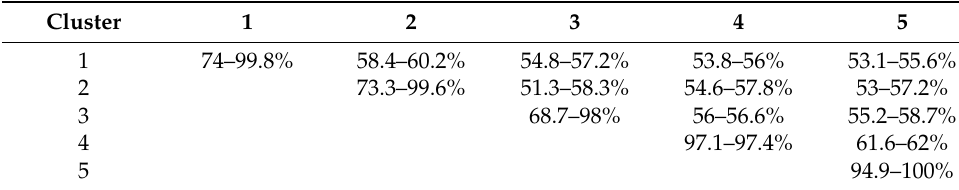
Table 3. Homology analysis of the σ C gene in different